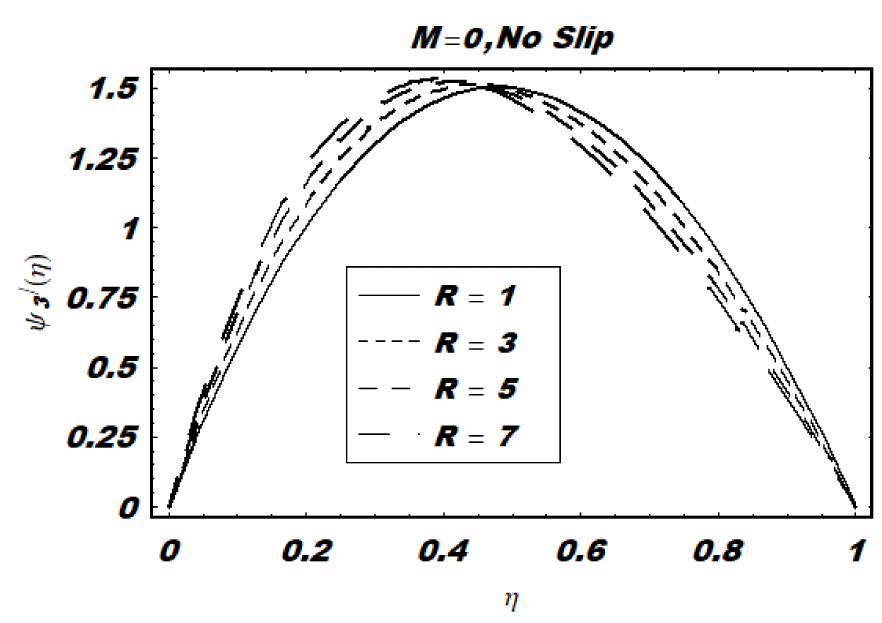
Figure 7. Similarity function ψ /